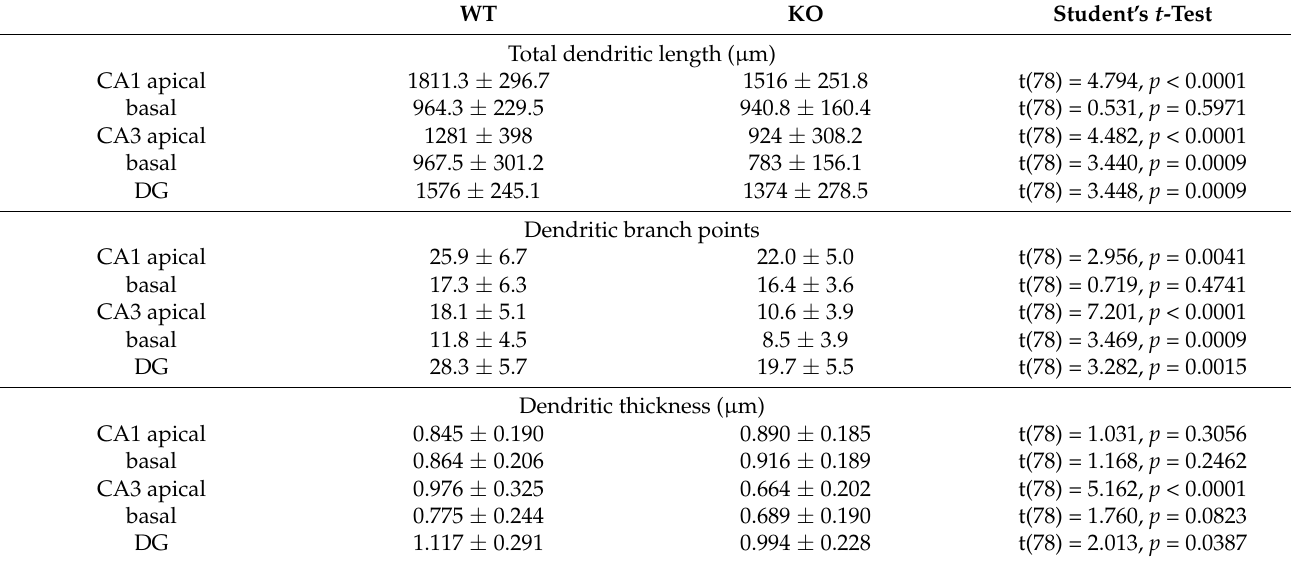
Table 2. Results of Student’s t -tests for total dendritic lengths, branch points, and thickness of the hippocampal neurons in each subregion between WT and KO mice ( n = 40 neurons/group). WT KO Student’s t